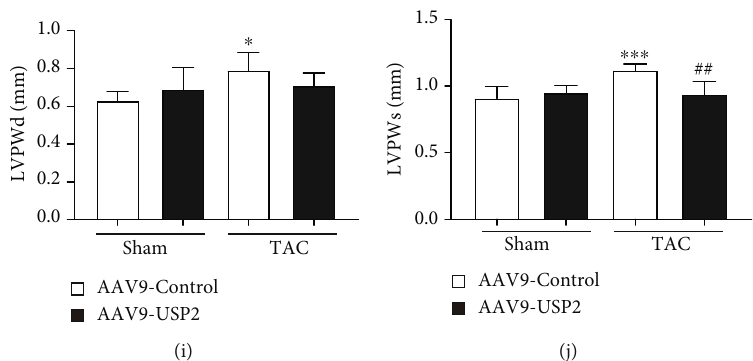
Figure 2: Overexpression of USP2 improves pressure overload-induced cardiac dysfunction. (a) Representative M-mode echocardiography of the left ventricular chamber and echocardiographic assessment of EF% (b) and FS% (c) from AAV-Control or AAV-USP2-treated mice following sham or TAC. Measurements of LVAWd, LVAWs, LVIDd, LVIDs, LAPWd, and LVPWs are shown in (d – i). ∗ P < 0 : 05 and ∗∗ P < 0 : 01 (AAV9-Control plus TAC vs. AAV9-Control plus sham); # P < 0 : 05 and ## P < 0 : 01 (AAV9-Control plus TAC vs . AAV9-USP2 plus TAC). n = 6